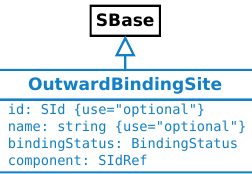
Figure 10: The definition of the OutwardBindingSite